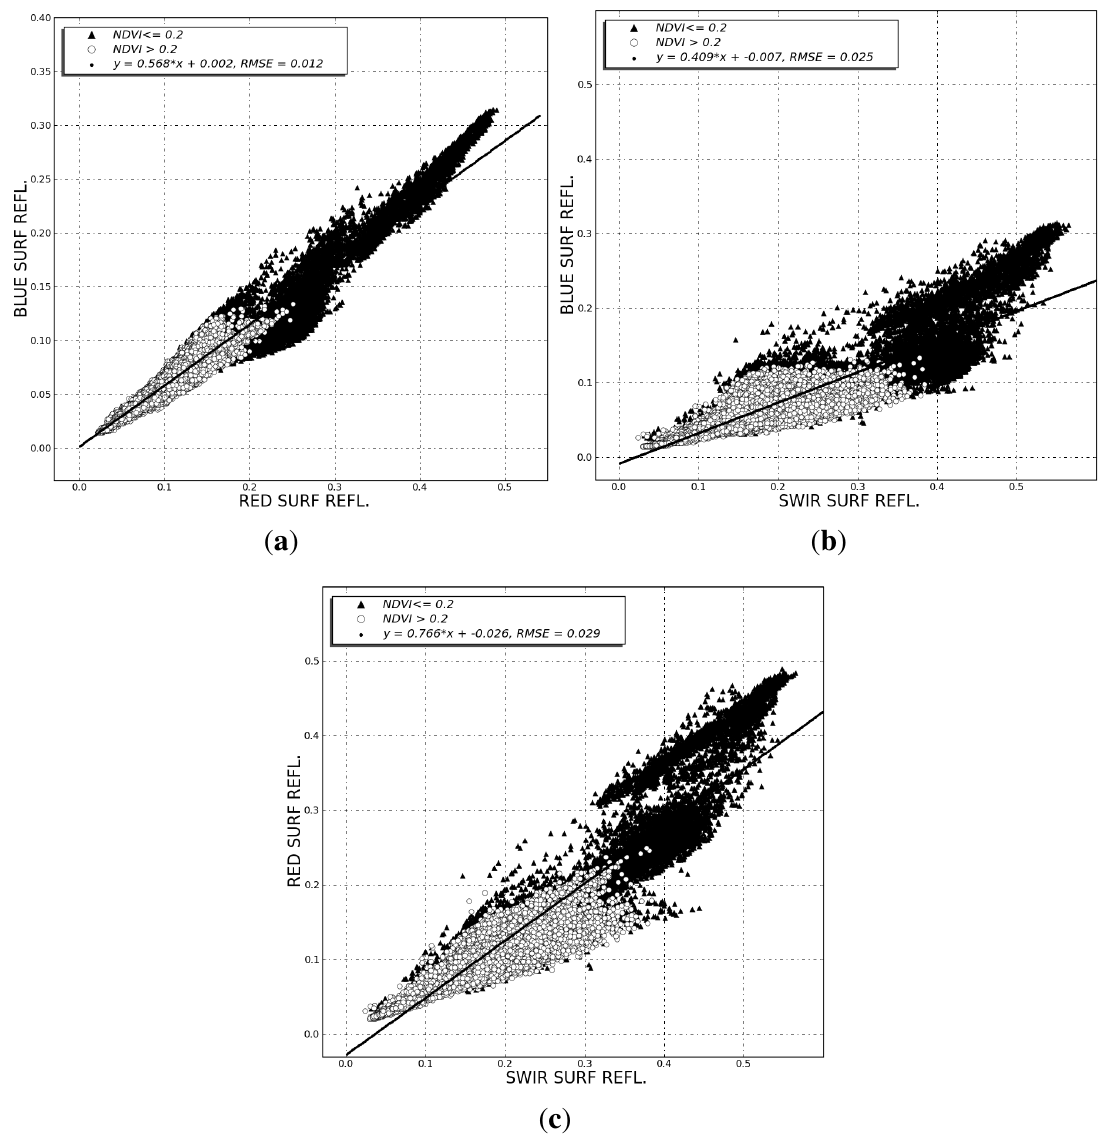
Figure 5. Surface reflectance linear regressions between the blue and SWIR (2.2 µ m) bands ( a ), red and SWIR bands ( b ) and blue and red bands ( c ). Dark dots correspond to NDVI lower than 0.2; lighter dots are for NDVI greater than